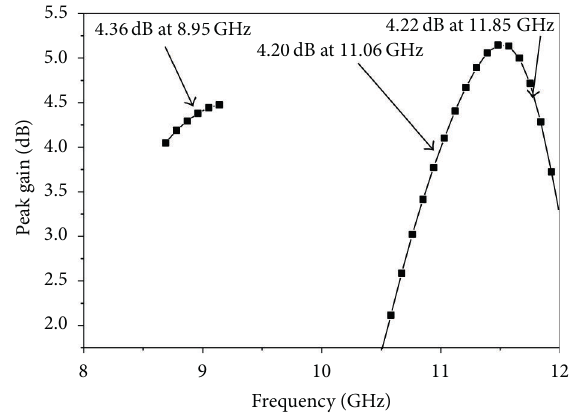
Figure 15: Peak gain of the proposed